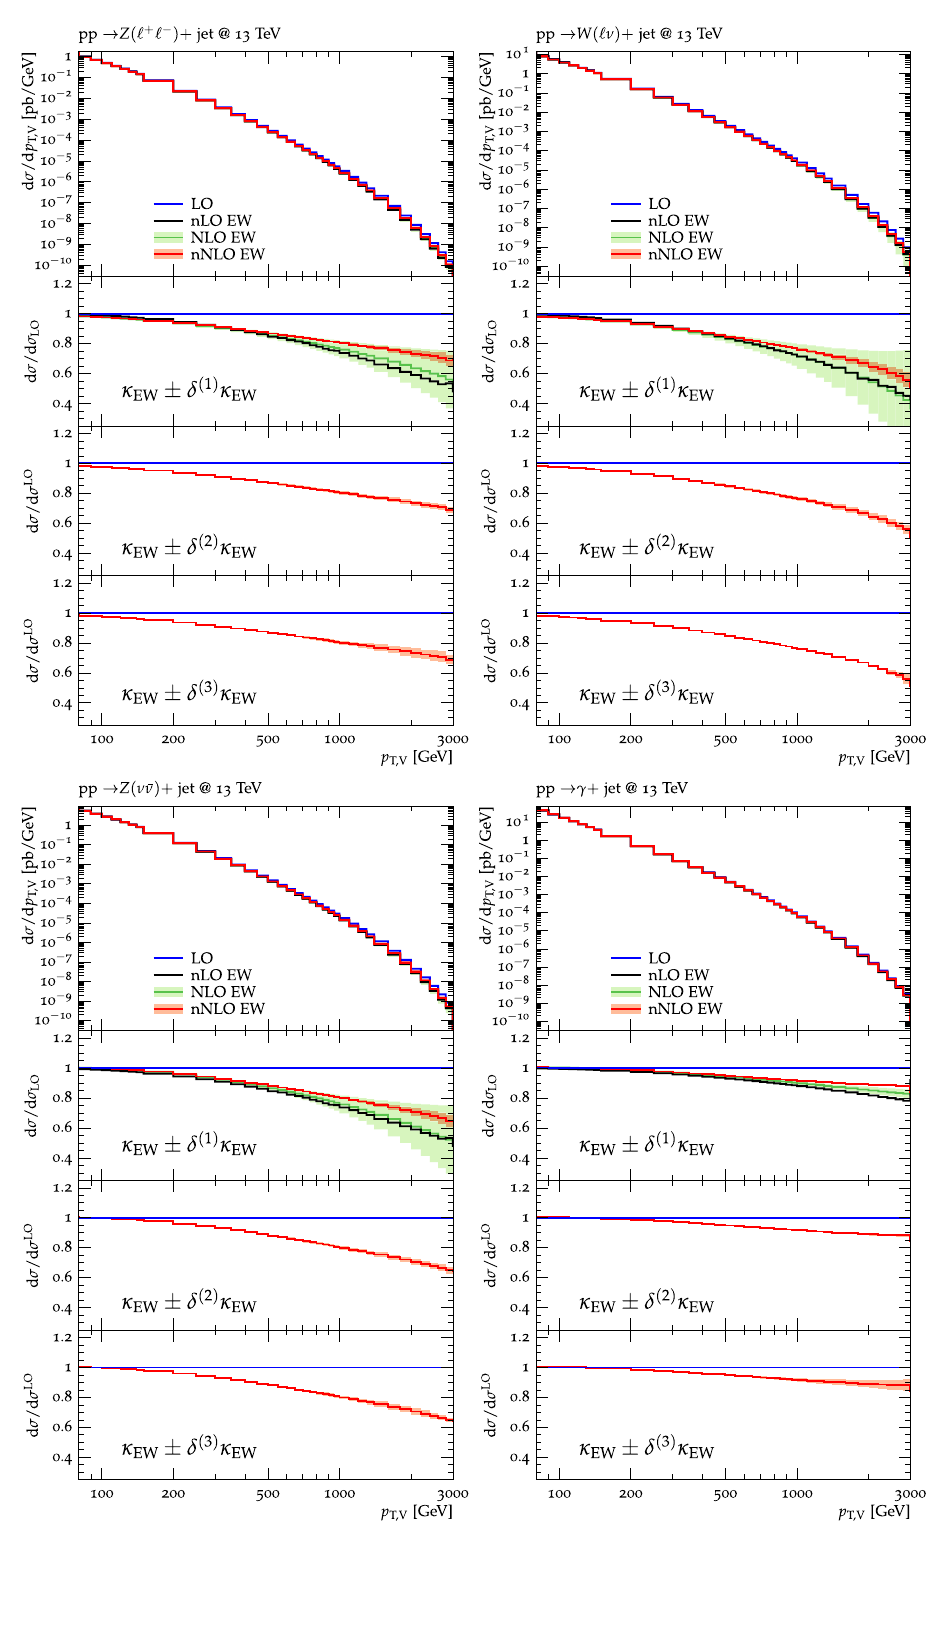
Fig. 20 Higher-order EW predictions and uncertainties for different pp → V + jet processes at 13TeV. The main frames display absolute predictions at LO (blue), NLO EW (green) and nNLO EW (red), as well as NLL Sudakov logarithms at NLO (black). The latter are dubbed nLO EW. In the ratio plots all results are normalized to LO. The bands correspond to the three types of ( V ) EW uncertainties, δ ( i ) κ . At EW nNLO EW (red bands) they are defined in Eqs. (52), (53) and (56), while at NLO EW (green band) only the uncertainty δ ( 1 ) κ ( V ) , defined in NLOEW Eq. (57), is